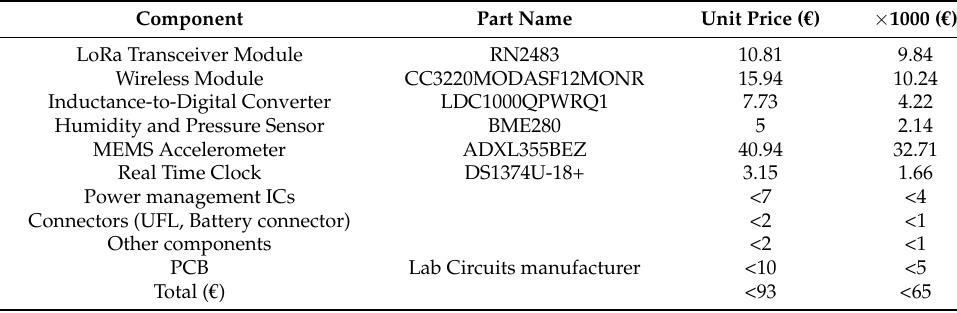
Table 1. Total cost of the sensor node materials.